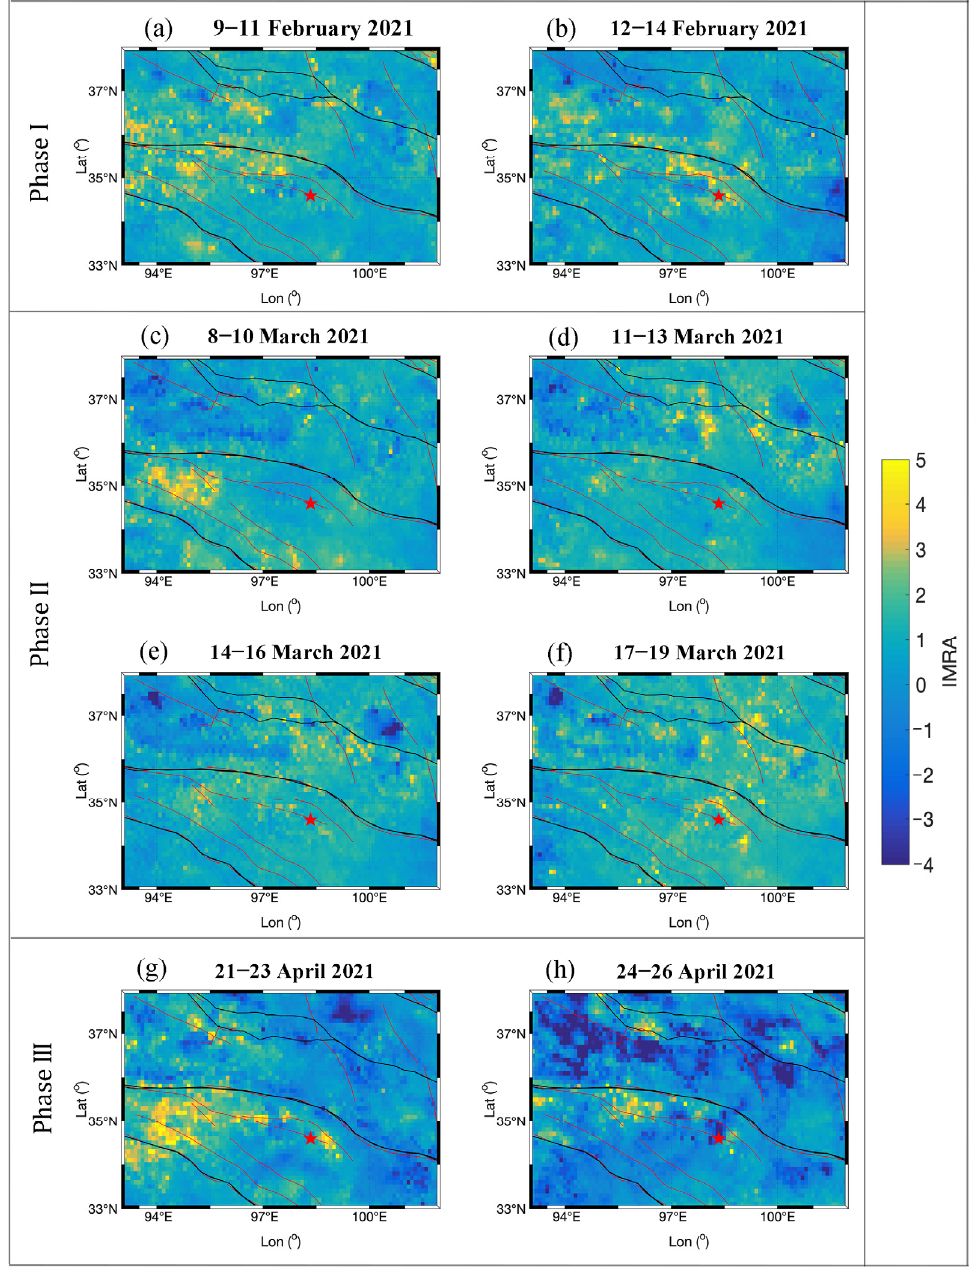
Figure 5. Spatial distribution of the IMRA during the three enhanced IMRA phases: ( a , b ) Phase I, ( c – f ) phase II, and ( g , h ) phase III. Black lines indicate the boundaries of tectonic blocks, and red lines indicate the main active faults.